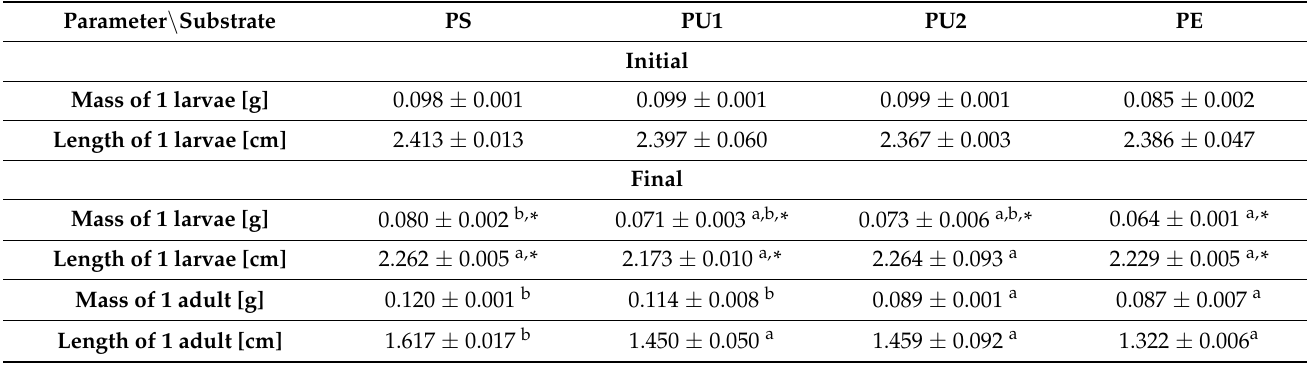
Table 2. Average length and fresh weight of the insects at the beginning and end of the experiment ( ± SD; n = 3).